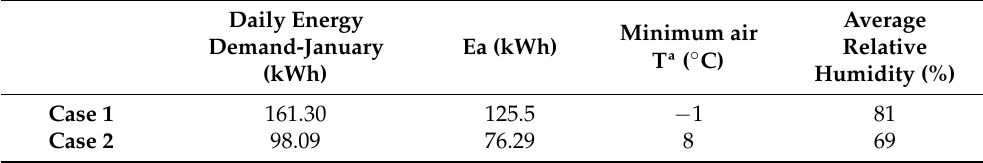
Table 6. External air energy required for the conditions of each study